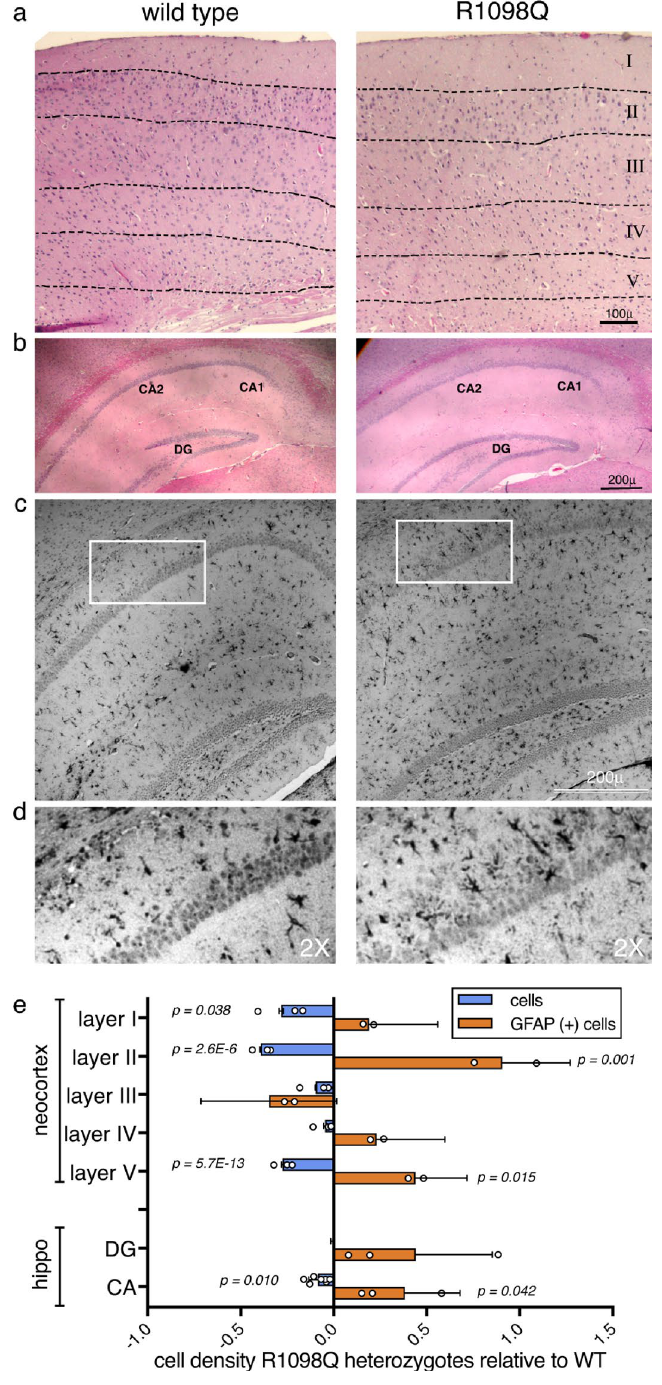
Figure 6. Degeneration of the neocortex and hippocampus in adult R1098Q mice. While not as dramatic as in the cerebellum, there is significant astrogliosis and neuronal loss in the cerebrum of 1.5 year old mice. ( a ) H&E stained neocortex exhibiting neuronal loss. When the cells per unit area and their GFAP staining were counted (below), losses and enhanced GFAP positive cells were significant in layers I, II and V. ( b ) H&E stained hippocampus. As in the neocortex, there is cell loss particularly in the CA1/CA2 regions. ( c ) GFAP immunostaining of the hippocampus exhibiting widespread astrogliosis. The region outlined is depicted in greater detail in panel ( d ), where the infiltration of astroglia is apparent throughout the CA1/2 layers in the R1098Q animals. ( e ) Comparison of changes in cell and astroglial (GFAP positive) density in R1098Q heterozygotes relative to the WT adult brains. The average density of cells in cortical layer I, layer II, and V are significantly reduced, while there is significantly increased numbers of GFAP cells per unit area in layers II and V. The CA1/2 region also exhibits less dramatic but still reduced cell counts, with marked increase in GFAP positive cells. There is no significant change in cell density in the dentate gyrus (DG), and the increase in GFAP positivity in this region also did not reach significance. For this analysis, images from comparable regions of two WT and two heterozygous mice were each divided into equal area units (18 to 46 units depending on the size of the region under consideration), and the number of cells in each unit area counted by three independent observers. All data for WT and het were then each pooled, and the average cell densities of each region calculated and compared (WT vs. het). Significance was evaluated by paired single-tailed